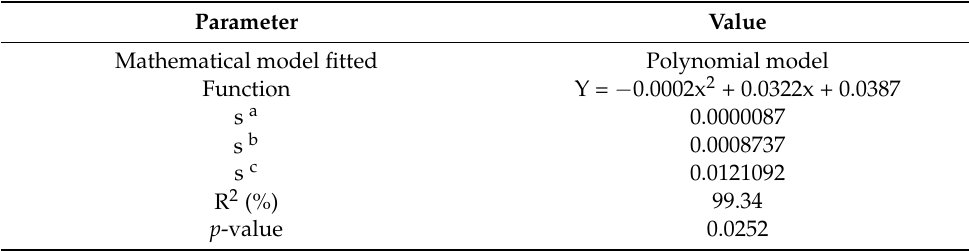
Table 7. Characteristic parameters of the standard calibration curve (calibration model) and the figures of merit of the ELISA